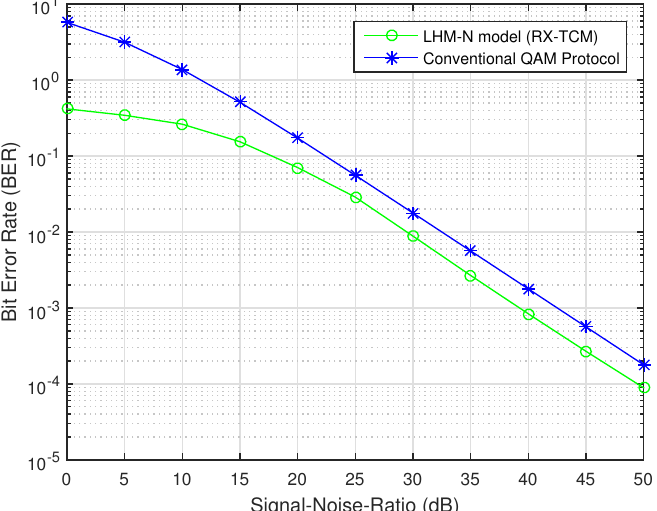
Figure 6. Comparative analysis of BER for LHM-N and the conventional QAM protocol.